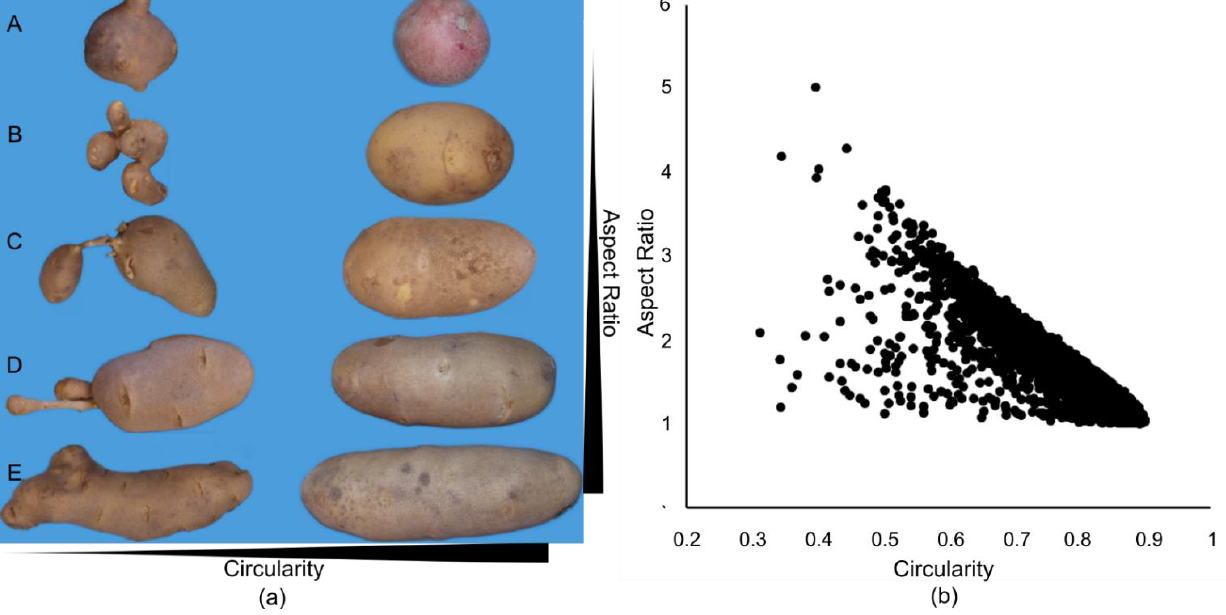
Figure 2. Aspect ratio versus circularity. ( a ) example tubers with ascending aspect ratio and circularity. ( b ) aspect ratio versus circularity plot for individual tubers.